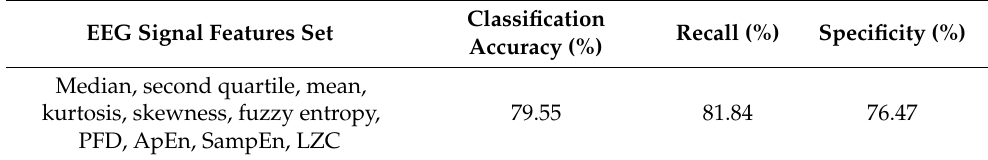
Table 5. The classification results of epilepsy and healthy control subjects by feature set input SVM